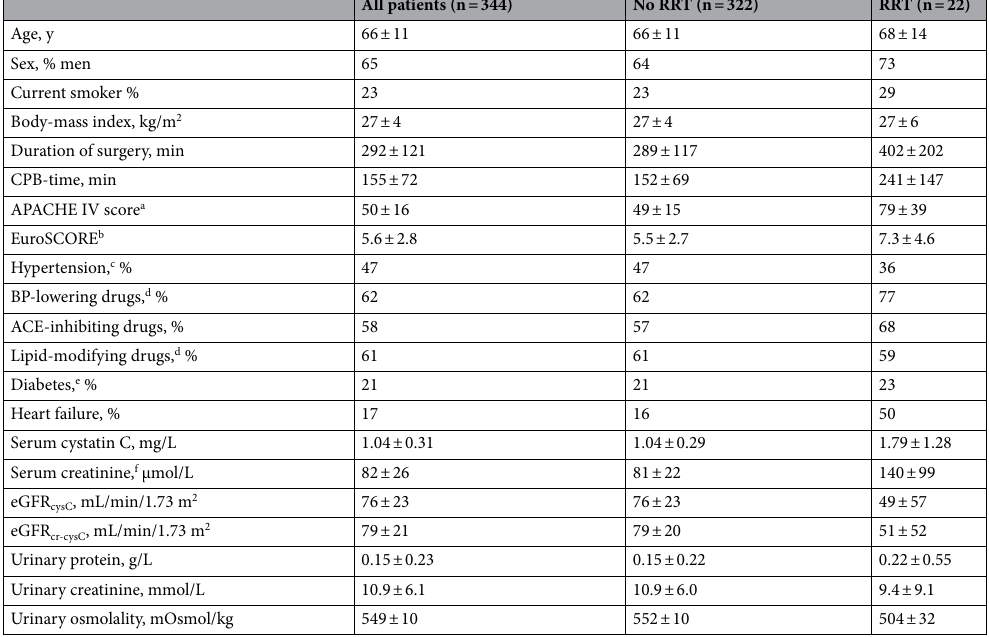
Table 1. Baseline characteristics of all 344 elective cardiac surgery patients and stratified according to start of renal replacement therapy (RRT). ACE, angiotensin-converting enzyme; BP, blood pressure; CPB-time, cardio-pulmonary bypass time; cr, creatinine; cysC, cystatin C; eGFR, estimated glomerular filtration rate; EuroSCORE, European System for Cardiac Operative Risk Evaluation. Data are reported as number of patients (%), mean ± SD or median (25th–75th percentile). The number of missing values was for serum cystatin C (n = 43), smoking (n = 19), BMI (n = 14), APACHE IV score (n = 12), urinary creatinine (n = 4), urinary protein (n = 3), ACE-inhibitors (n = 3), statins (n = 3), antihypertensive medication (n = 3), EuroSCORE (n = 2), serum creatinine (n = 1). Other variables had no missing values. a The APACHE IV score included information on age, temperature, mean arterial pressure, heart rate, respiratory rate, oxygenation, arterial pH, serum sodium and potassium, urine output, serum creatinine, liver function, hematocrit, white blood cell count, Glasgow Coma Scale, and presence of several chronic health conditions. b The EuroSCORE consists of 17 items, including age, sex, chronic pulmonary disease, previous cardiac surgery, serum creatinine, left ventricular dysfunction, and whether a procedure was planned or emergency 22 . c Diagnosis by a physician according to electronic medical records. d Blood pressure-lowering drugs ATC codes C02, C03, C07, C08, and C09. Lipid-modifying drugs ATC code C10AA. e Self-reported diagnosis by a physician, use of glucose-lowering drugs, or hyperglycemia. f To convert the values for creatinine to mg/dL divide by